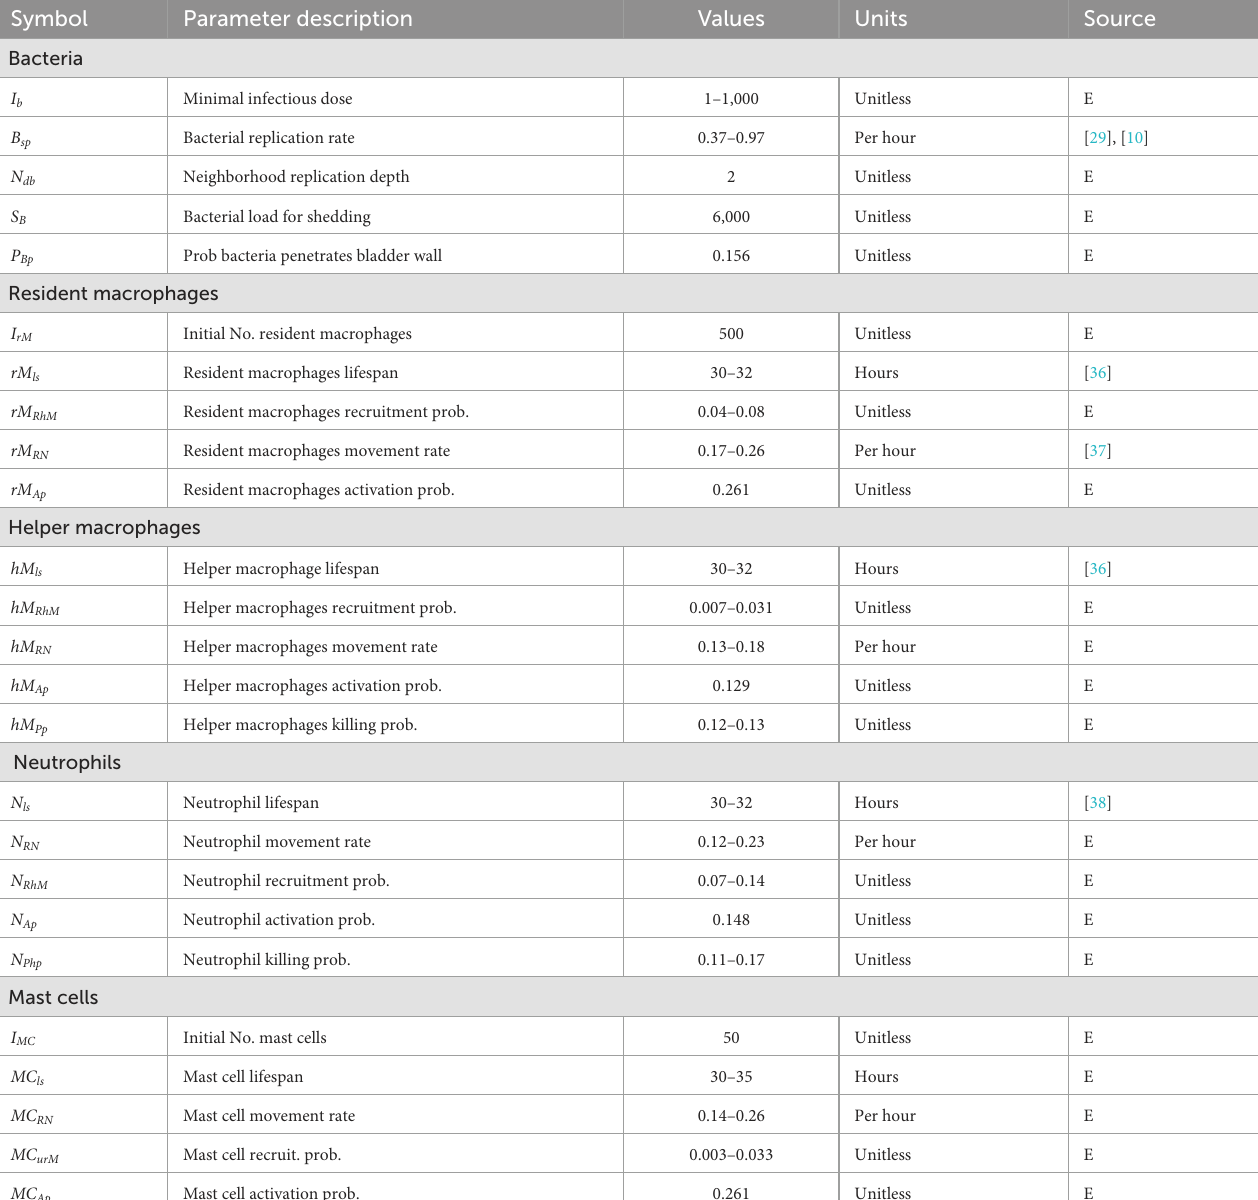
TABLE 1 Table of model parameter